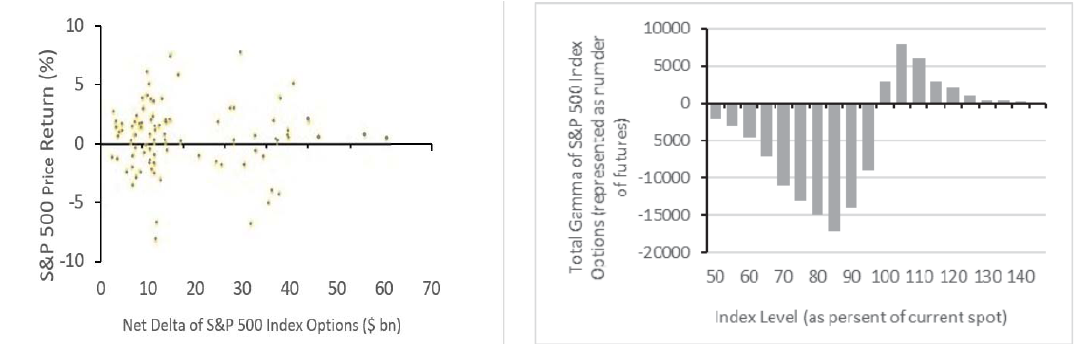
Fig. 3. Expiration week return vs. net-delta of front-month S&P options on previous Friday Source: Deutsche Bank